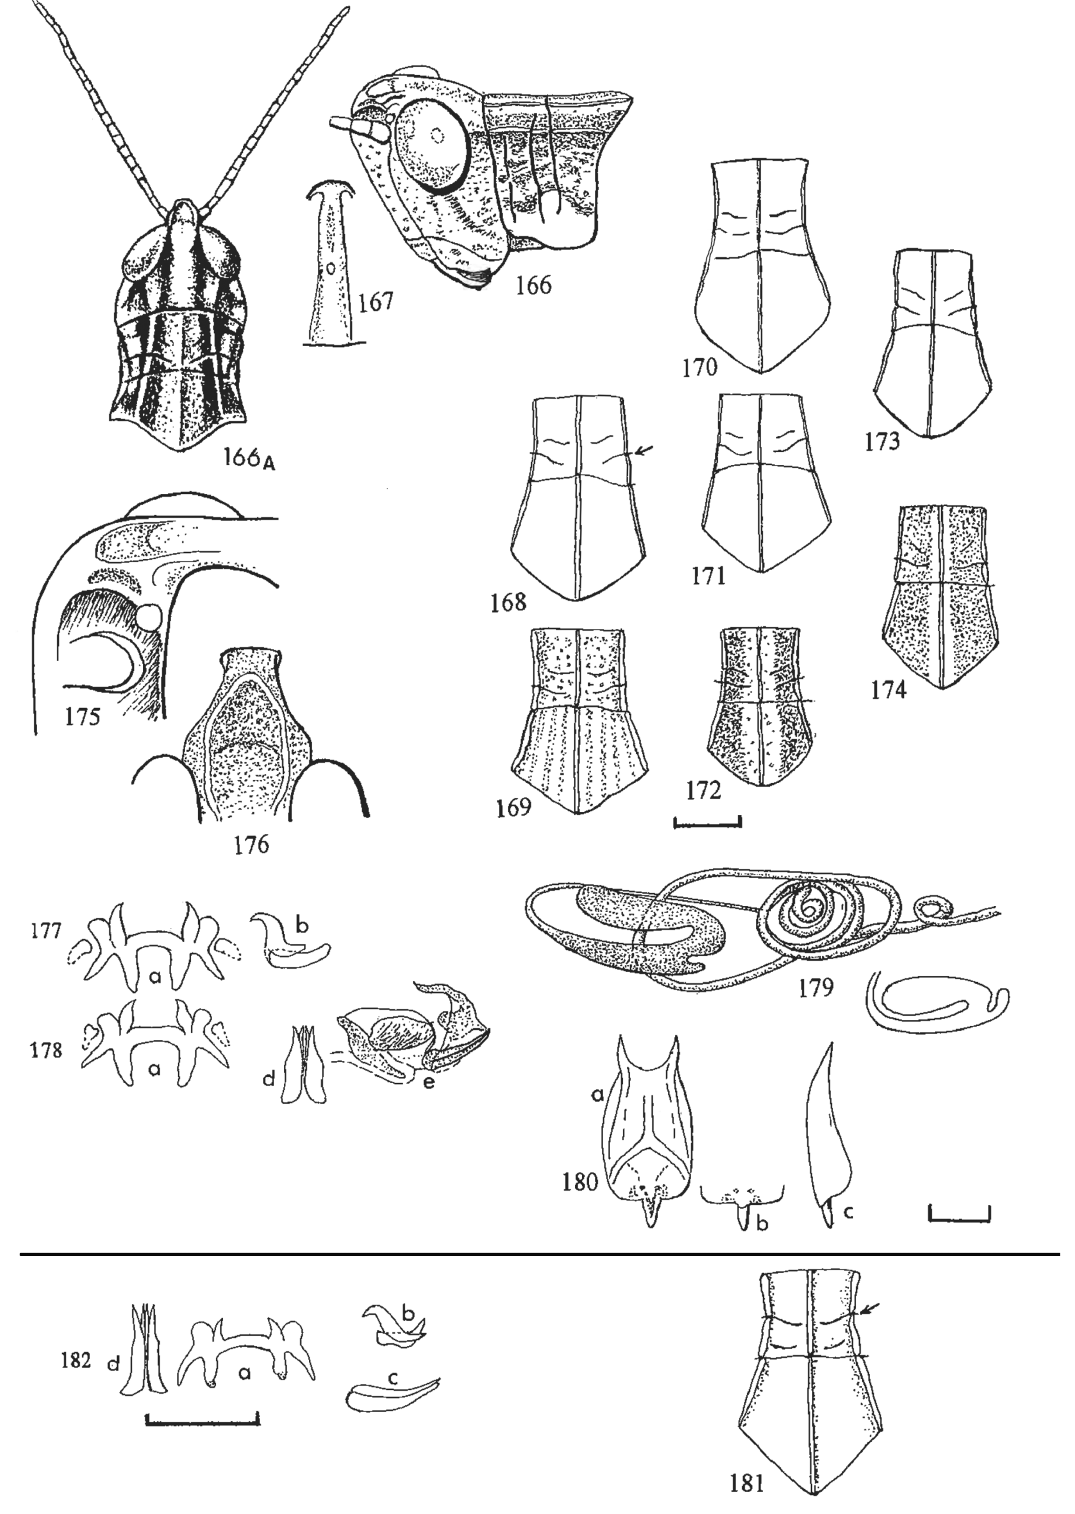
Figs 166–182. Tribe Gymnobothrini. Figs 166–180 . Gymnobothrus lineaalba : 166A. Orthochirista variegata Sjöstedt ( n. syn. of Gymno- bothrus lineaalba) , reproduced from Sjostedt (1931). 166. Oblique view head and pronotum; 167. Frontal ridge; 168–174. Variation in pronotal disc; 175. Oblique view vertex; 176. Dorsal view vertex; 177, 178. Variation in phallic structures; 179. Female spermatheca; 180. Female subgenital plate A. Dorsally and its apex B. Ventrally and C. Laterally. Figs 181, 182. Gymnobothrus carinatus: 181. Male pronotal disc; 182. Epiphallus and aedeagal valves. Scale lines all represent 1 mm: bottom left scale under Fig. 182 applies to Figs 175– 179, 182; scale under Fig. 172 applies to all the